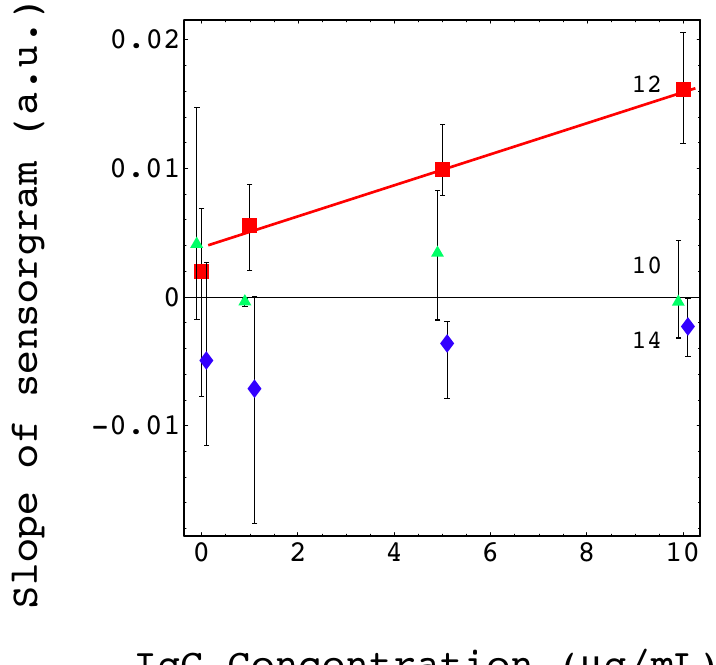
Figure 5. Calibration curve of the SPR immunoassay measured with a spiked antigen in non-homogenized milk. The relationship between the antigen concentration and the slope of the sensorgrams. Specific antigen-antibody pair 12 (squares) and non-specific pairs 10 (triangles) and 14 (diamonds) are shown in the same graph. A small offset in the horizontal axis was used for non-specific pairs to give clear view of the error bar overlaps. The solid line in the graph is the result of linear regression analysis applied to the specific